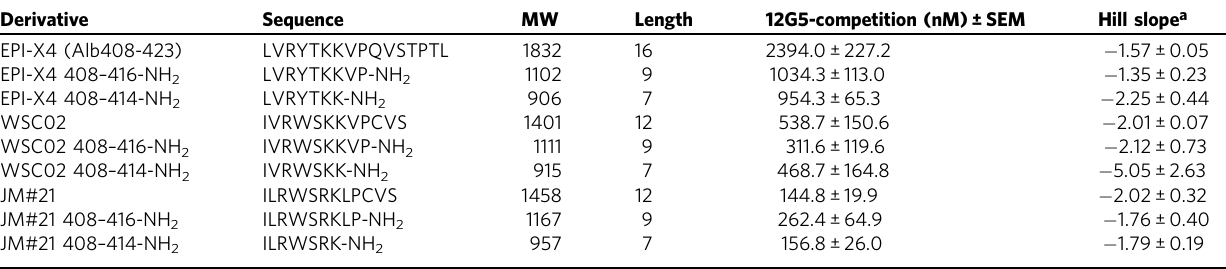
Table 2 Length-optimized derivatives of EPI-X4, WSC02, and JM#21.